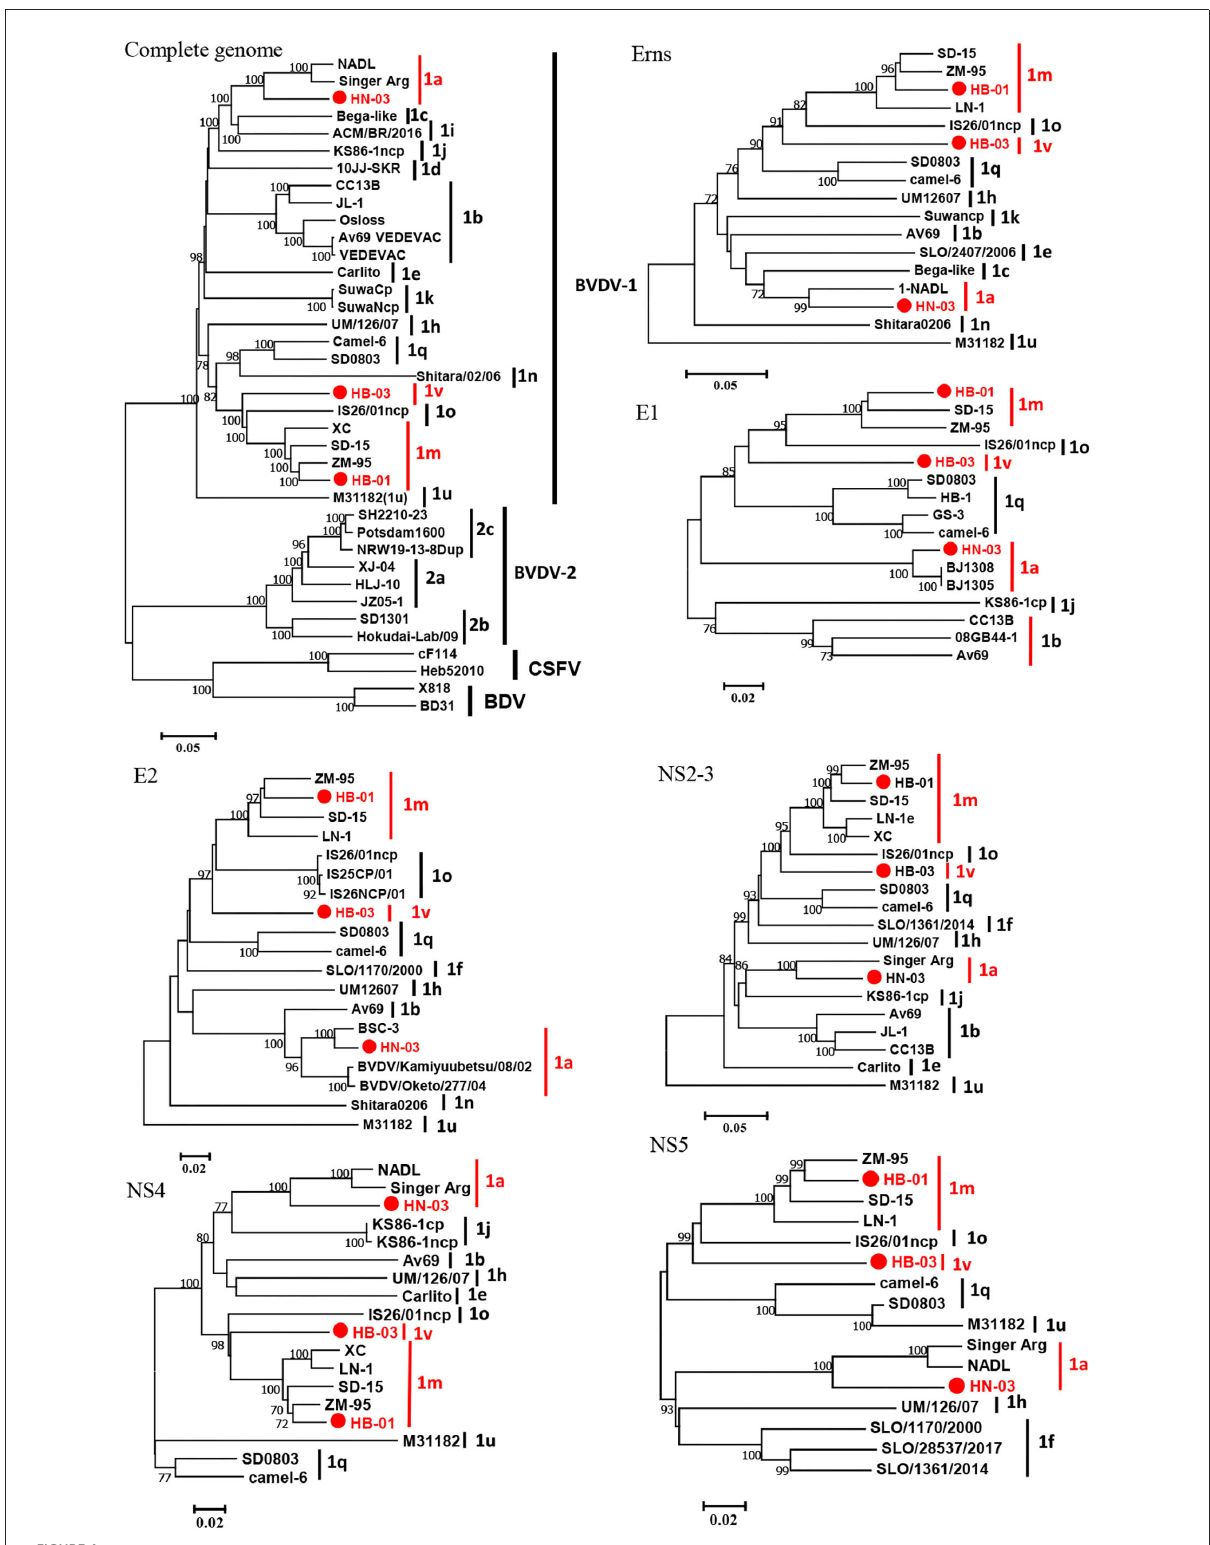
FIGURE4 Phylogenetic tree of the nucleotide sequences of the complete gene and six segments (Erns, E1, E2, NS2-3, NS4, and NS5). Molecular evolutionary genetics analysis was performed with MEGA 7 (Molecular Evolutionary Genetics Analysis) using the neighbor-joining (NJ) and bootstrap analysis ( n = 1,000) method. Unrooted trees described the relationship between sequences retrieved from the GenBank database and the three bovine viral diarrhea virus (BVDV) isolates analyzed in this work (red circle). Information on the reference strains is shown in Supplementary Table